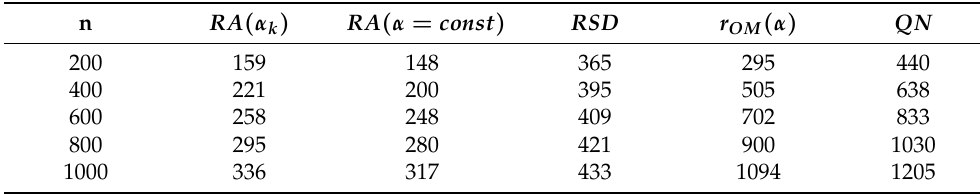
Table 3. Function f 3 ( x ) minimization results.